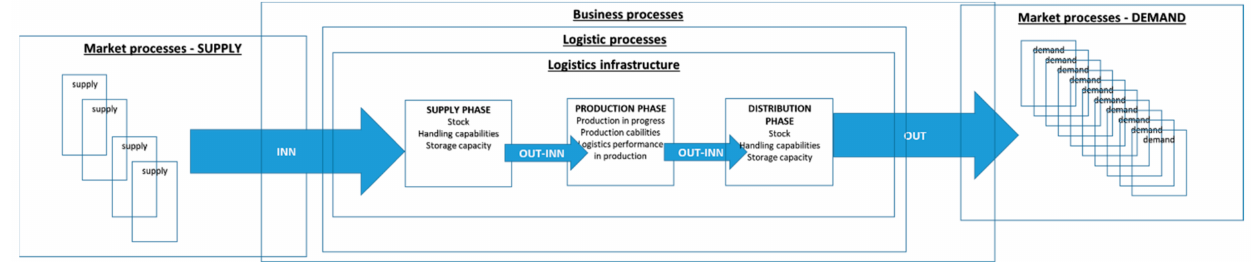
Figure 2. Graphical presentation of the logistics system model in phase